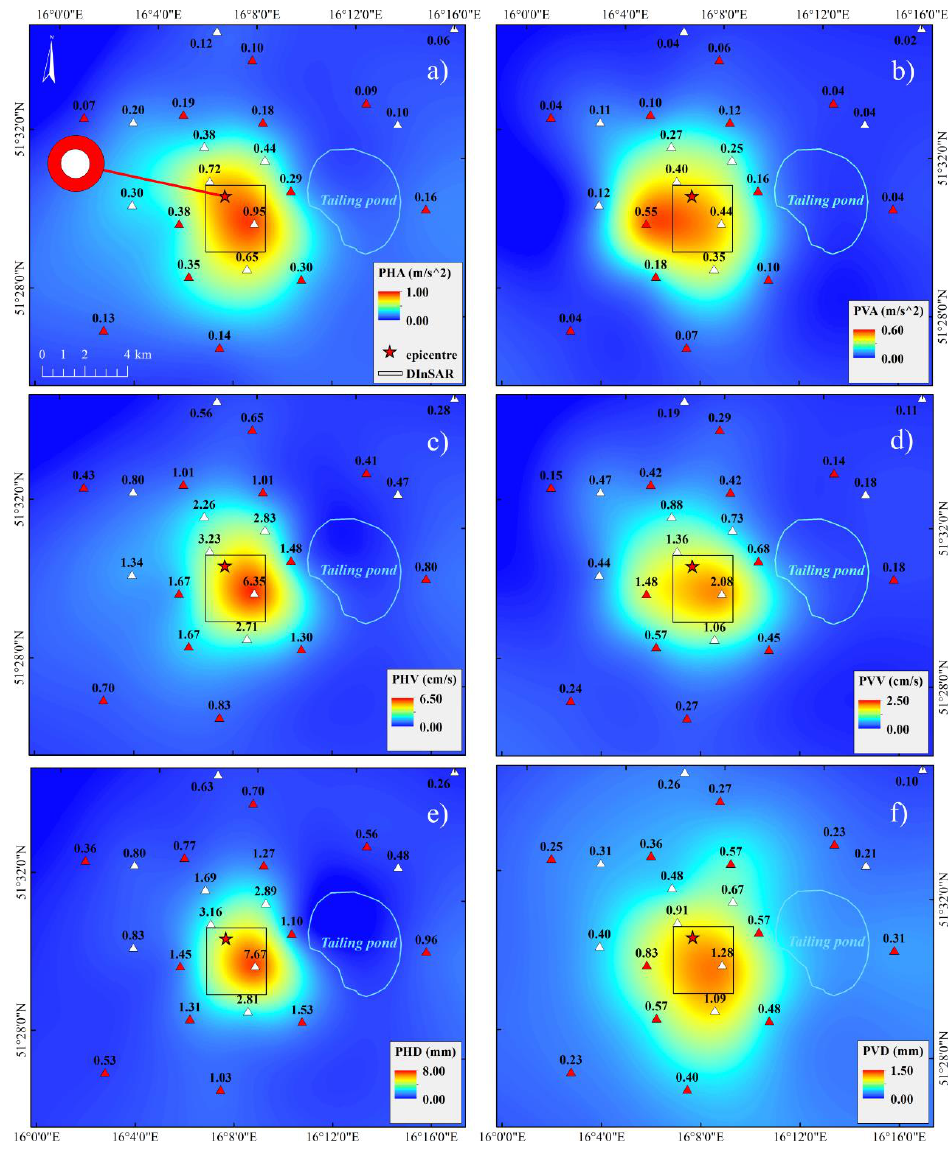
Figure 2. Peak ground acceleration: ( a ) horizontal (PHA) and ( b ) vertical (PVA); peak ground velocity: ( c ) horizontal (PHV) and ( d ) vertical (PVV); and peak ground displacement: ( e ) horizontal (PHD) and ( f ) vertical (PVD) estimated from the local LUMINEOS network record, represented as triangles. Red—seismometers. White—strong motion sensors. The location of the estimated epicentre is indicated by a star, and the beach ball represents the focal mechanism in ( a ). The black rectangle shows the range of the DInSAR plots illustrated in Section 4.2.